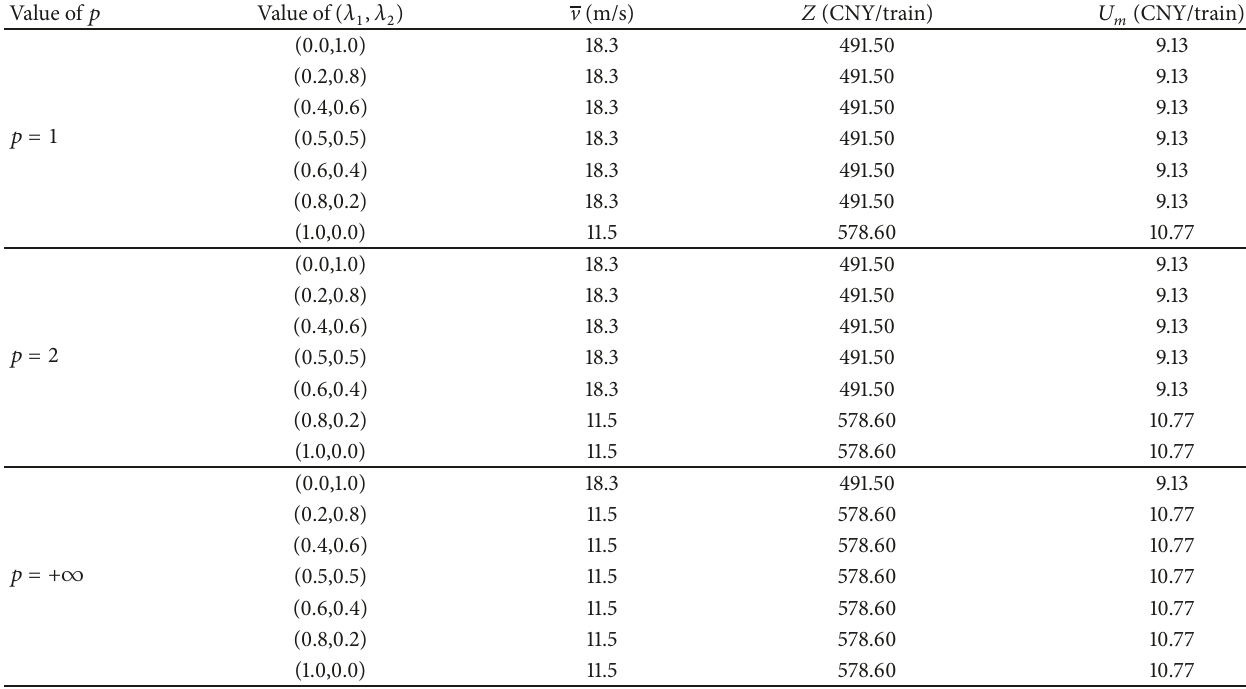
Table 4: The objective function values and the respective optimal train operating speed obtained by the fuzzy multiobjective optimization algorithm.